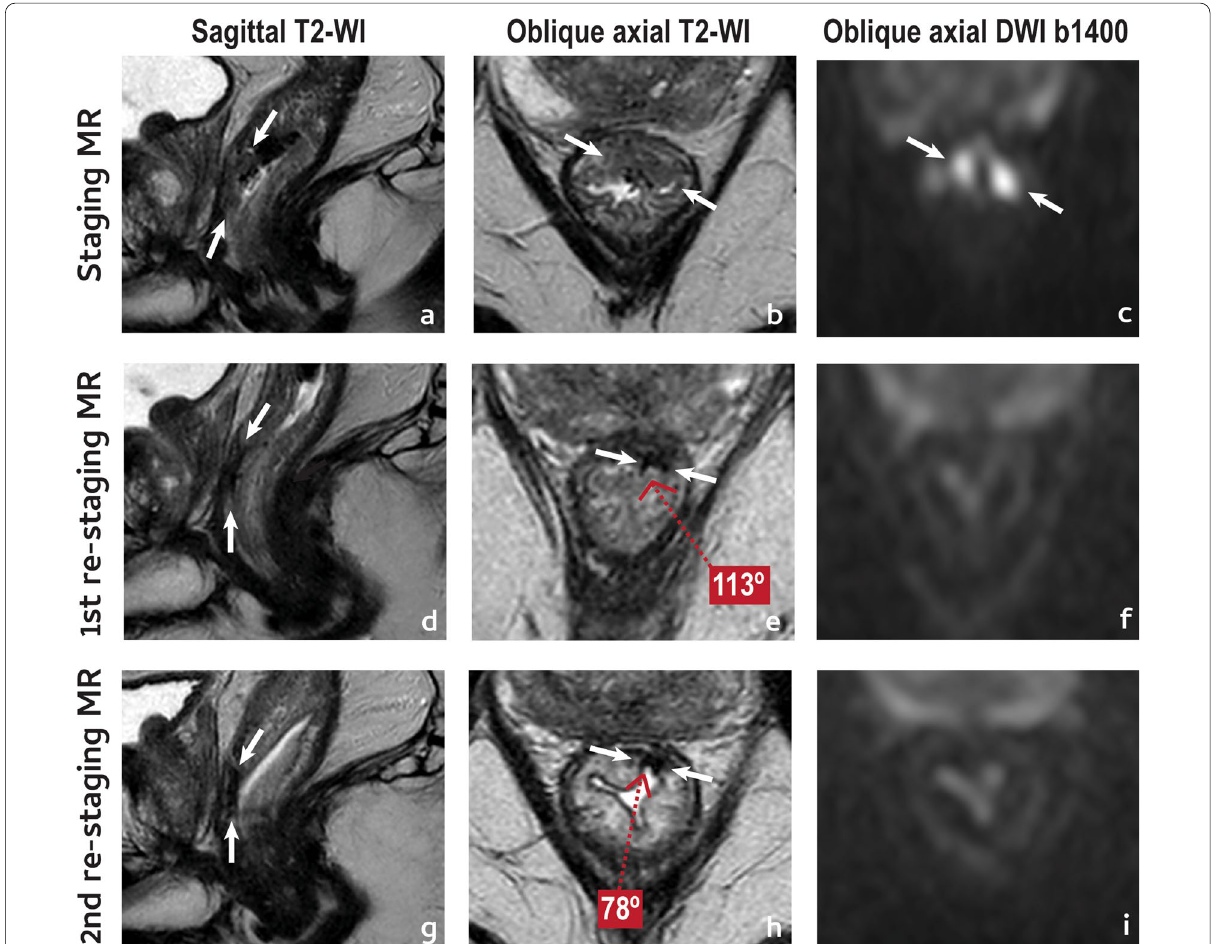
Fig. 6 Complete tumour response. A 61 year-old male presented with a low anterior mrT2 (between arrows in a – c ) mrN1a (not shown) EMVI rectal cancer. He underwent NAT and was re-staged at 11 weeks ( d – f ). Reduction in tumour size was considerable, > 80% ( d, e ). On T2-WI, the tumour was reduced to a thin, crescentic, endoluminal hypointense “fibrotic” scar (mrTRG1, split scar sign signal intensity was visible ( f ). Notice how the scar “curled-in” between first and second assessment ( e , h , respectively), reducing its depth angle significantly ( 35°). Patient is currently on W&W with no signs of disease recurrence at 1 −